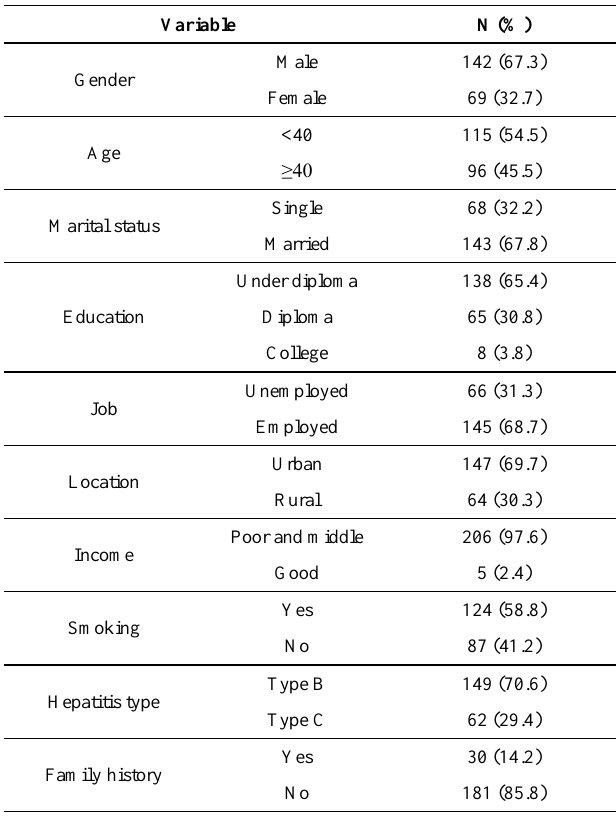
Table 1. The frequency of demographic